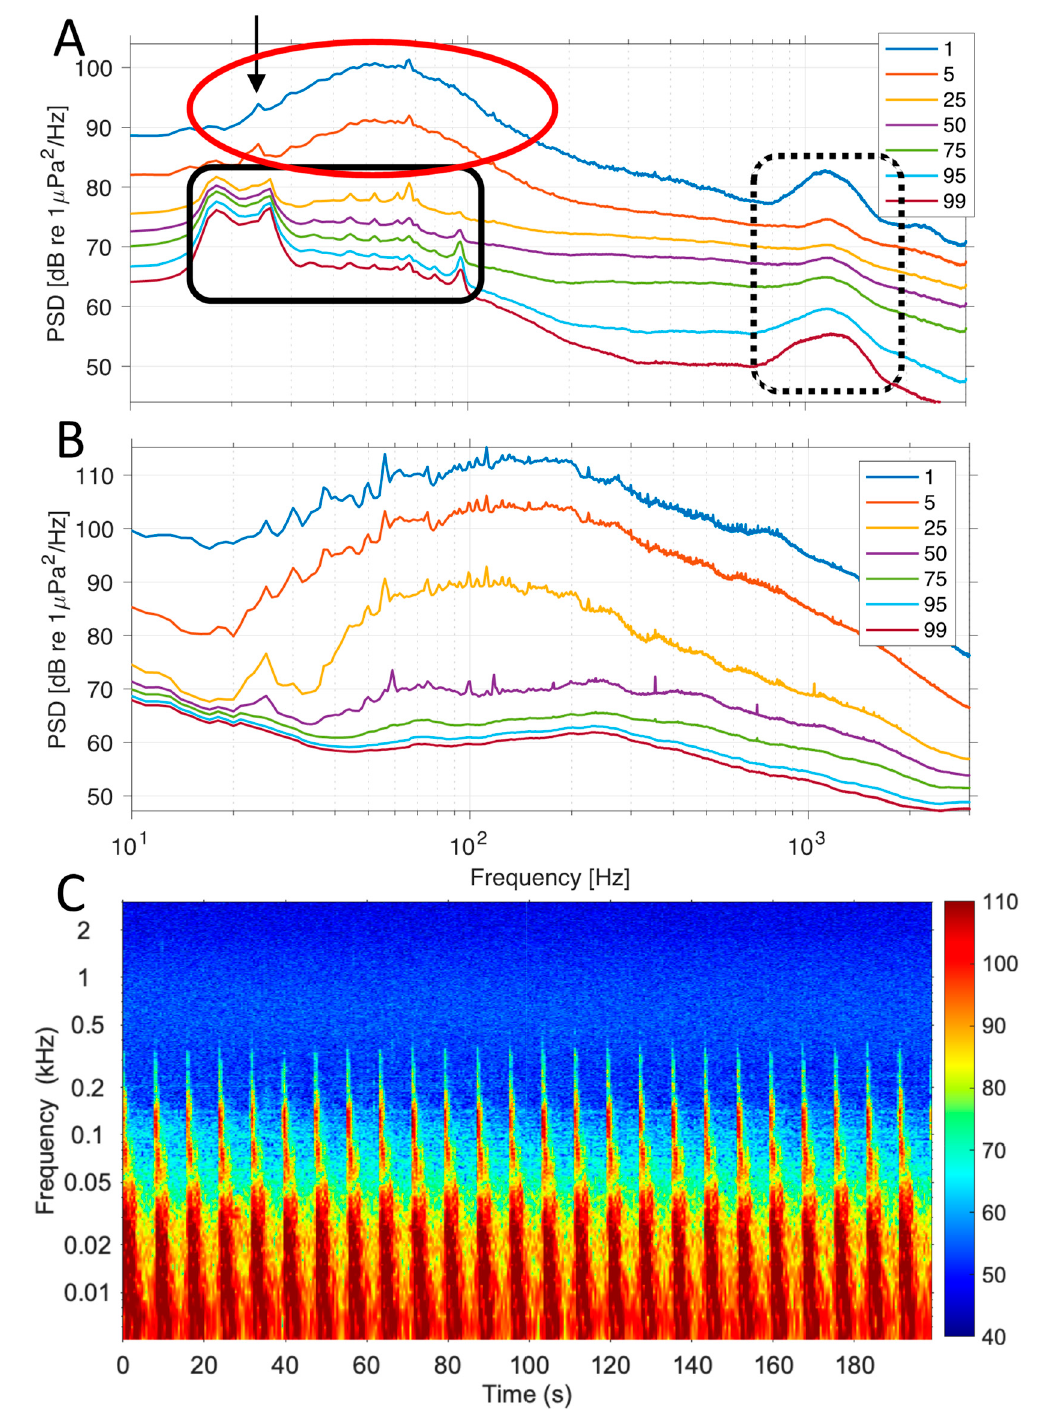
Figure 12. ( A ) Power spectral density percentiles of the winter soundscape at site 23 showing that pygmy blue whales (black box) were present the entire 6 months (because the spectral shape of their song is seen even in the 99th percentile, meaning it did not become quieter than this). However, the strongest sound in this soundscape came from ships (identified by the broad and smooth spectral hump between 20 Hz and 200 Hz; red ellipse). The spot call was also strong at this site (marked by the black arrow). The fish chorus at 800–2000 Hz (dotted box) was present the entire time as well; ( B ) Power spectral density percentiles from site 2 being entirely dominated by broadband industrial noise of unknown origin at this time; ( C ) Spectrogram of a strong seismic survey temporarily present at site 3; no other sounds were visible.